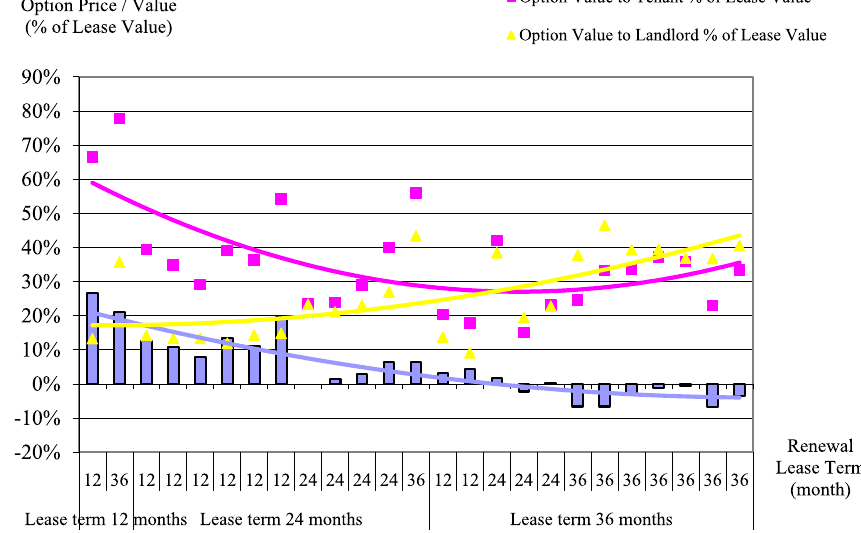
Fig. 5 Option value/price with original and renewal lease